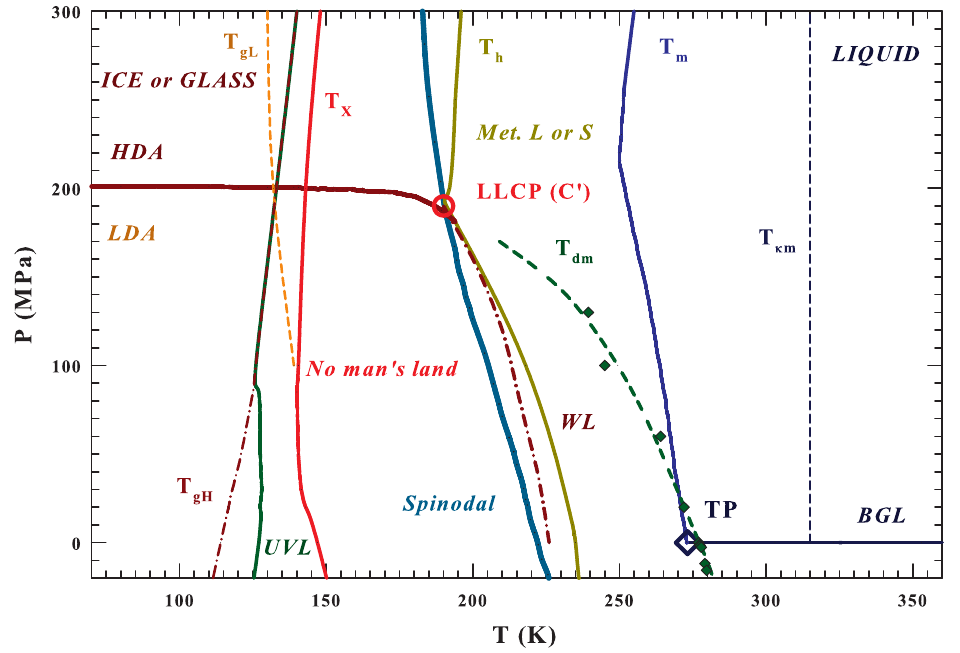
Figure 1. The water phase diagram in the T − P plane. The following temperature lines are illustrated: the melting T M , the homogeneous nucleation T H , the density maxima T dm , the κ T minima T κ m , the Widom line WL , and the crossover under stable conditions from the liquid to the crystal phase T X [12,20] The positions of the proposed liquid-liquid critical point C (cid:48) (estimated value [11,53])) and the triple point, TP , the spinodal line (obtained from the IAPWS EoS [54]) and the binodal gas liquid ( BGL ) are also reported. Finally, the existence areas of the ultraviscous liquids ( UVL ) and the two amorphous phases LDA and HDA (together with their respective glass transition lines, T gL and T gH ) are proposed together with the regions characterized by the liquid polymorphysm ( LDL and HDL ) [9]. Bulk water density isobars, from 0.1 to 800 MPa and the temperature range 100 < T < 370 K (i.e., from the regions of the two amorphous LDA and HDA phases and supercooled liquid state to the region of the boiling temperature), are illustrated in Figure 2. These literature data also refer to bulk liquid water inside the metastable supercooled region T h < T m [3,19,56–61] and to LDA and HDA [6,30–32]. The dashed green line represents the locus of the density maxima ρ max ( P , T ) . For comparison purposes, Figure 2 also reports, data of bulk water density at ambient pressure in other conditions: (i) ice Ic; (ii) under confinement in nanotubes [51,52]; and, (iii) the results of a MD simulation of the state equation by using the TIP4P/2005 model